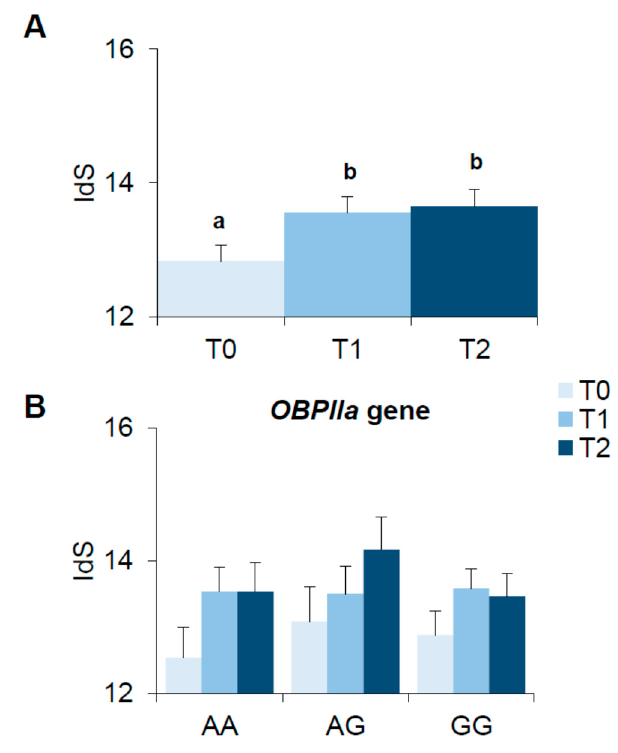
Figure 4. Means ( ± SEM) values of the odor identification score (IdS) determined before (T0), one month (T1) and six months (T2) after bariatric surgery ( n = 51) ( A ). The same data are shown for each genotype of the rs2590498 polymorphism of OBPIIa gene (genotypes AA: n = 15; genotypes AG: n = 12; genotypes GG: n = 24) ( B ). Different letters indicate a significant difference ( p ≤ 0.0056, Fisher’s test LSD, subsequent repeated measures ANOVA).